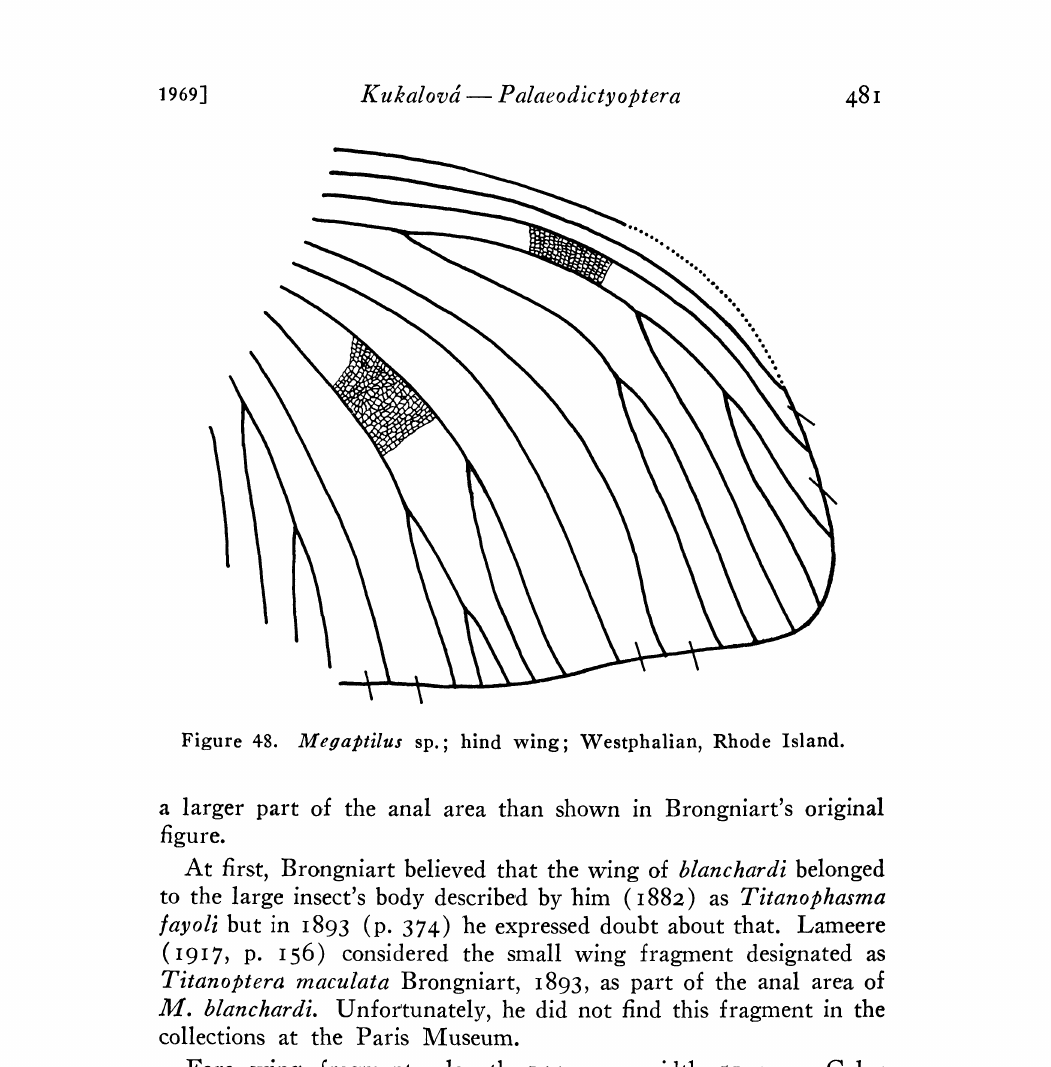
Figure 48. 21egaltilus sp.; hind wing; Westphalian, Rhode Island. a larger part of the anal area than shown in Brongniart’s